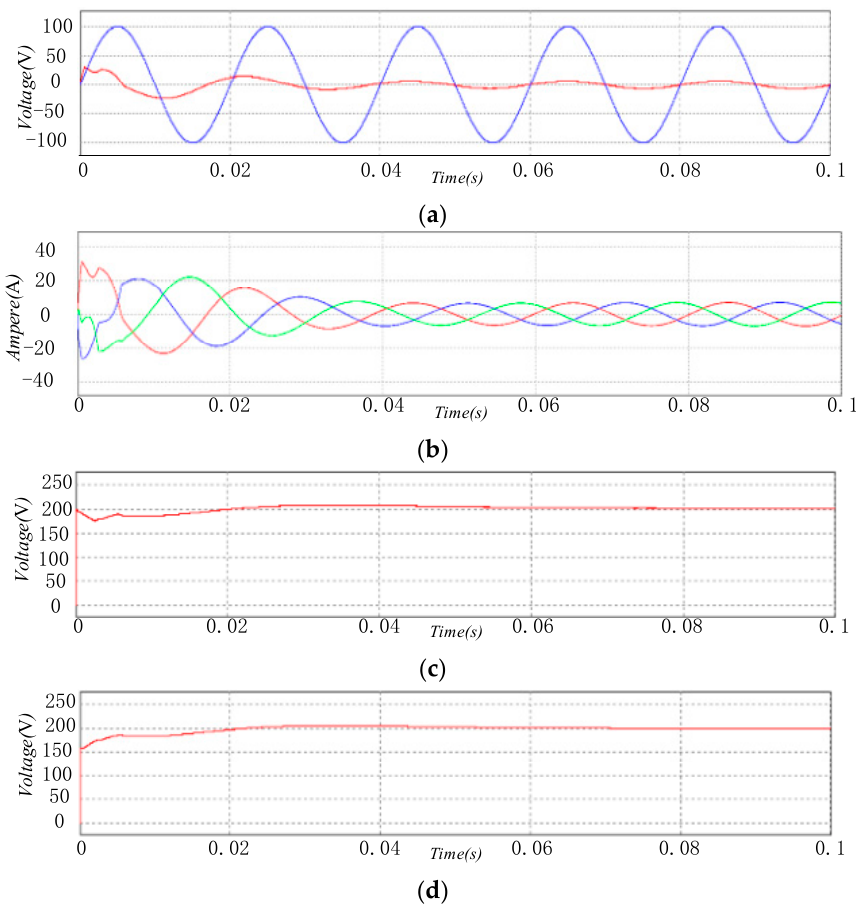
Figure 16. Output voltage simulation curve of cascade system. ( a ) The three-phase ac side a-phase voltage and current waveform; ( b ) The current curve of the AC side; ( c ) The output voltage waveform of the DC side of the PWM rectifier; ( d ) Output voltage waveform of LLC resonant converter.